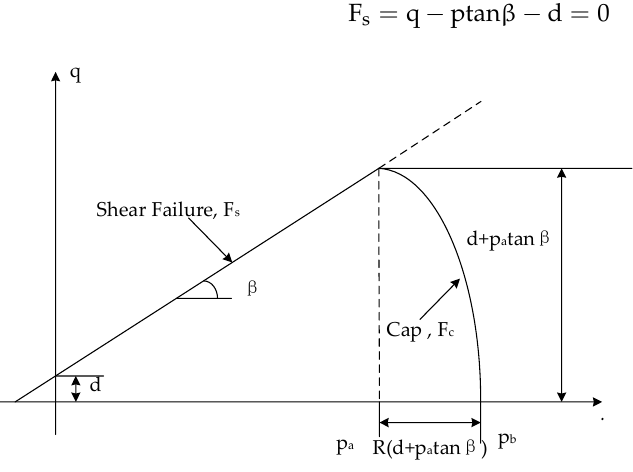
Figure 1. Failure surface of the Cap model in p – q plane